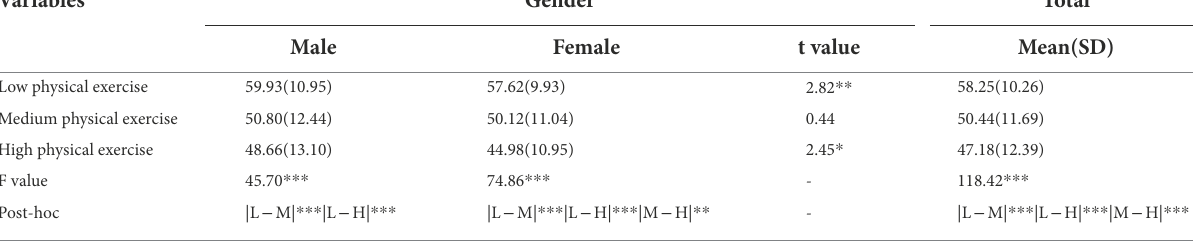
Table 3 Comparison of mean (SD) of academic burnout among college students in different physical exercise groups.